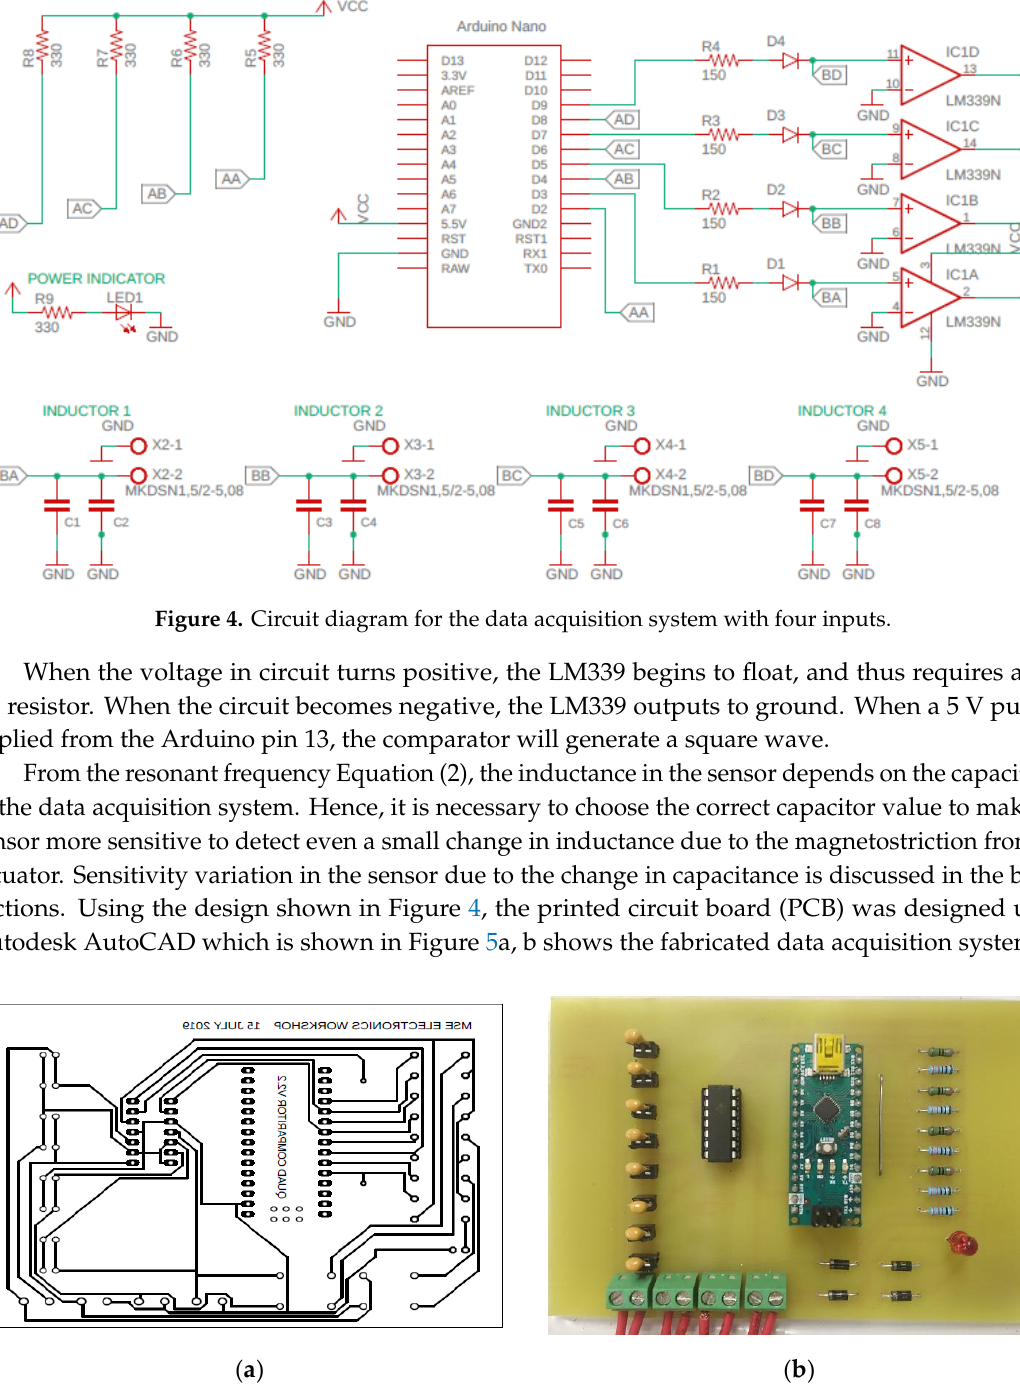
Figure 5. ( a ) Design of PCB ( b ) Fabricated PCB